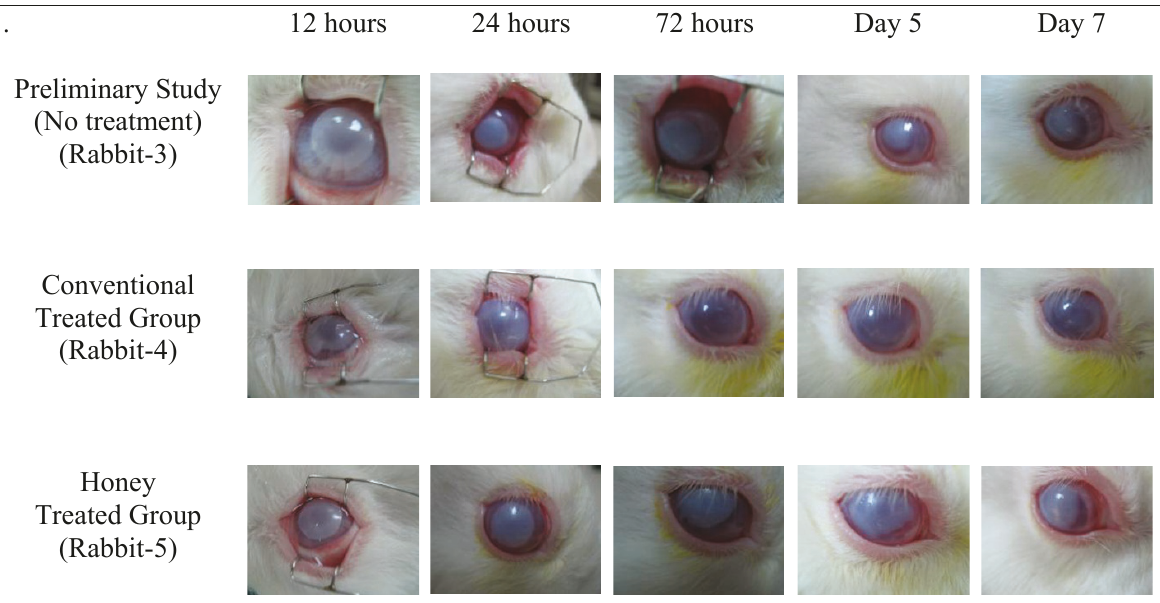
Figure 1 Conjunctival hyperemia and corneal edema post induction of alkali injury on rabbit ’ s cornea .